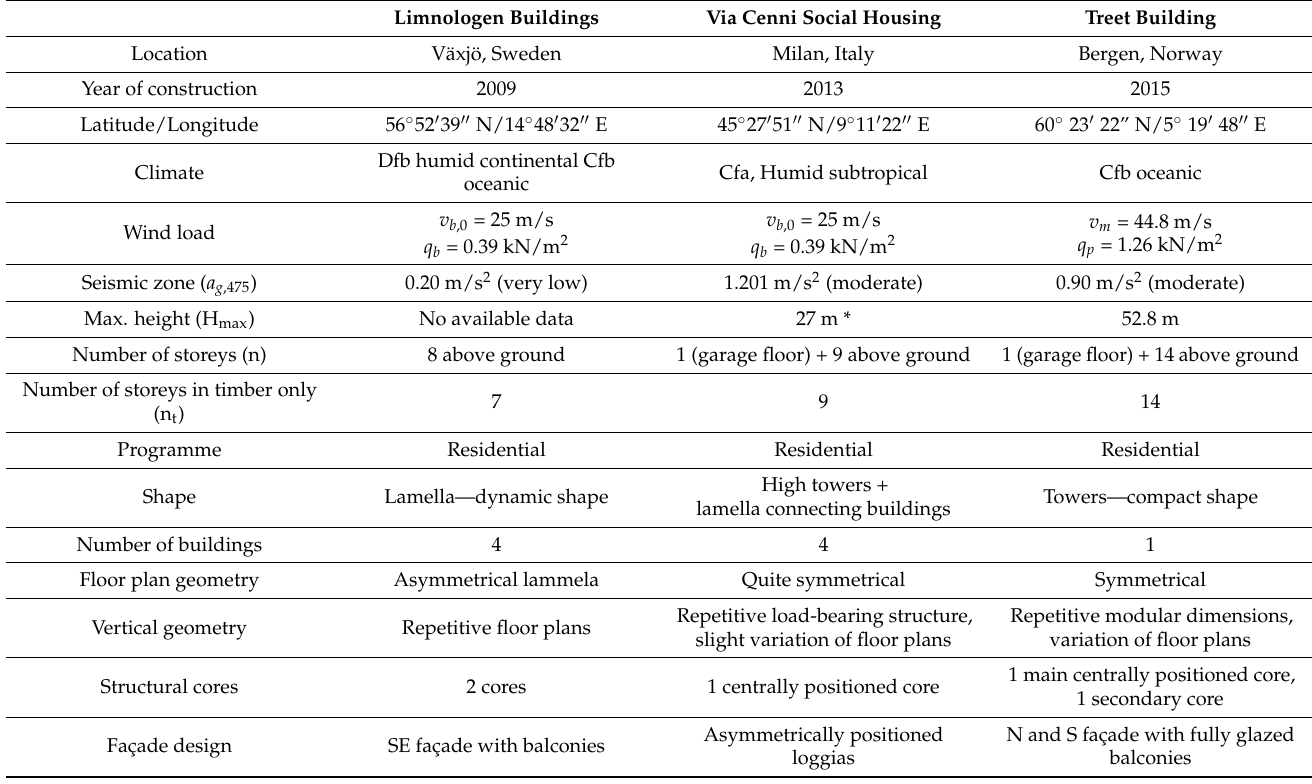
Table 2. Main boundary conditions and properties of the selected projects under